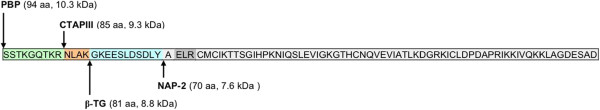
Amino acid sequences of β-thromboglobulin-like proteins [36].